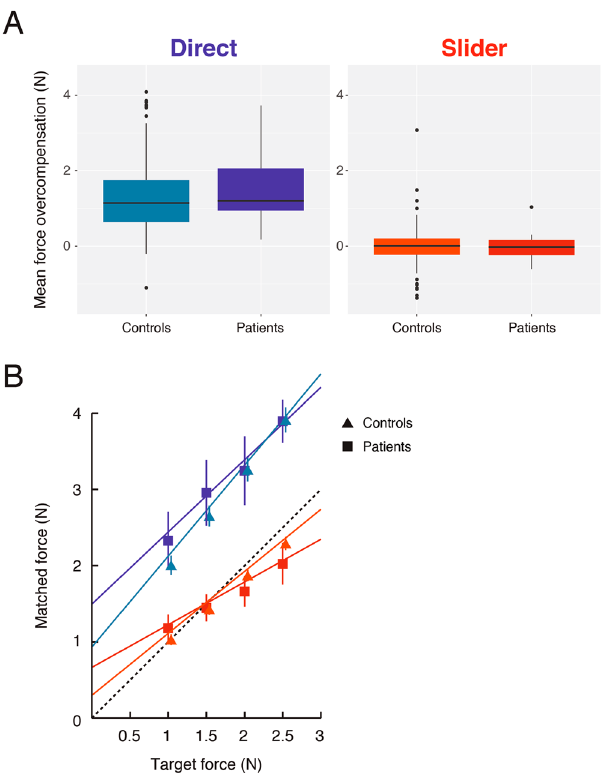
Figure 2. Differences in sensorimotor attenuation between PD patients and controls. ( A ) Standard boxplots showing the distribution of mean force overcompensation values across all patients and controls in the Direct (shades of blue) and Slider (shades of red) conditions. Positive value indicates sensory attenuation. ( B ) Mean regression plots of matched versus target force in the Direct and Slider conditions for both groups. Colour scheme is the same as in ( A ). Dashed line indicates the line of equality. Error bars indicate ± 2 standard error of group mean. Control data points and error bars are offset by 2 pixels for